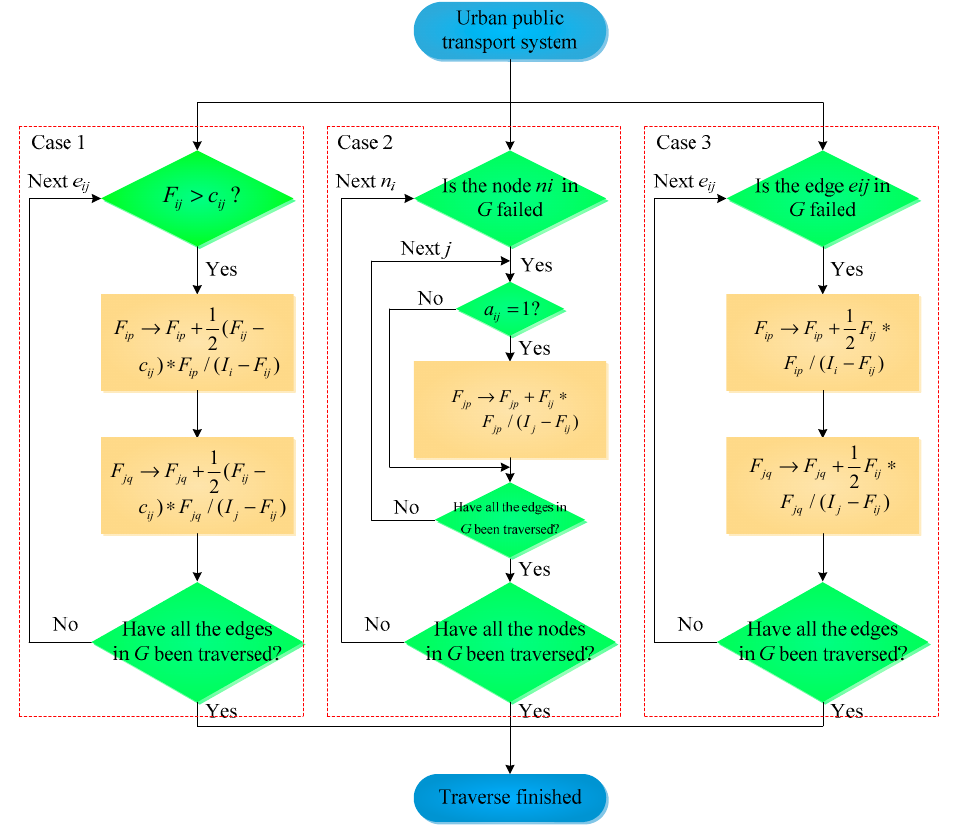
Figure 4. Transfer rules of passenger flow.